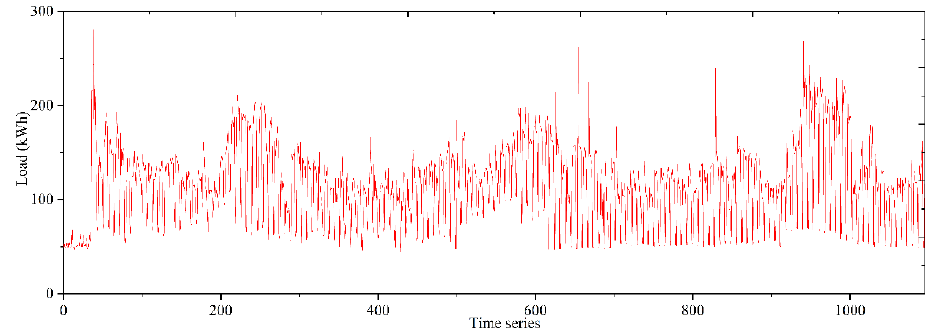
Figure 4. Energy consumption of Building 185 from 2016 to 2018.